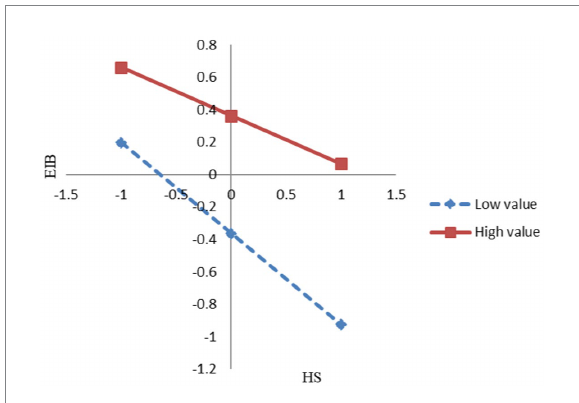
FIGURE 3 The moderating effect of employment relationship atmosphere